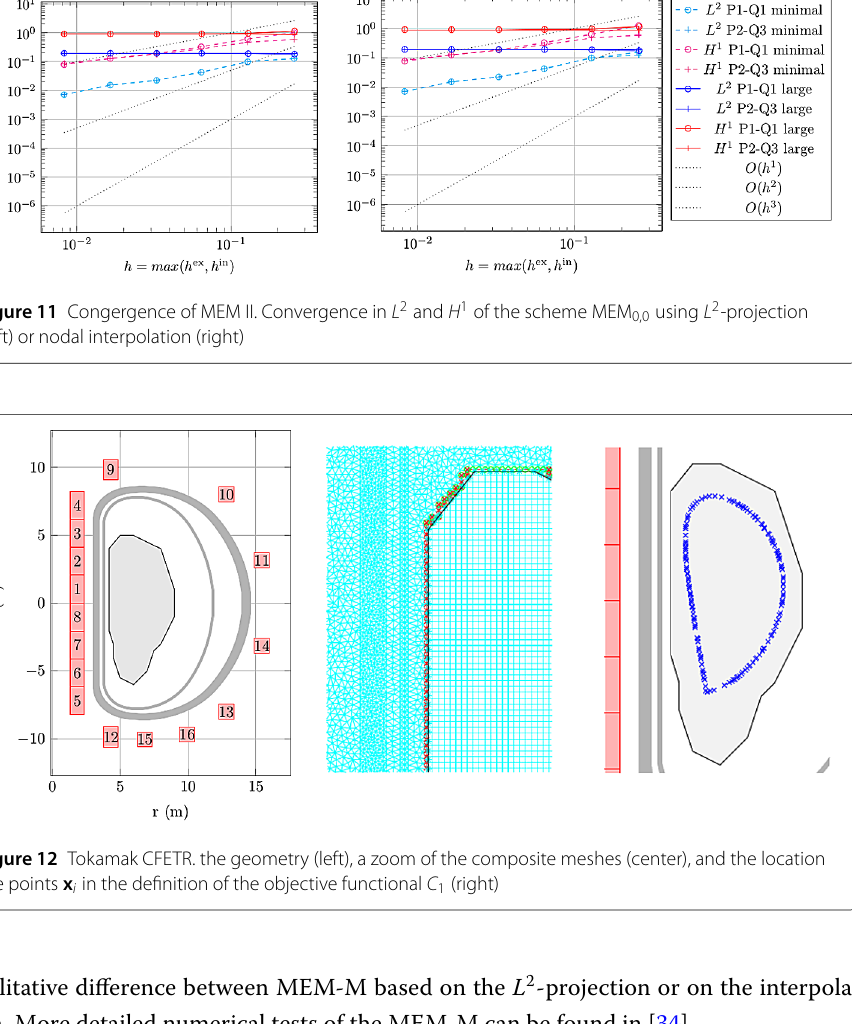
qualitative difference between MEM-M based on the L 2 -projection or on the interpola- tion. More detailed numerical tests of the MEM-M can be found in